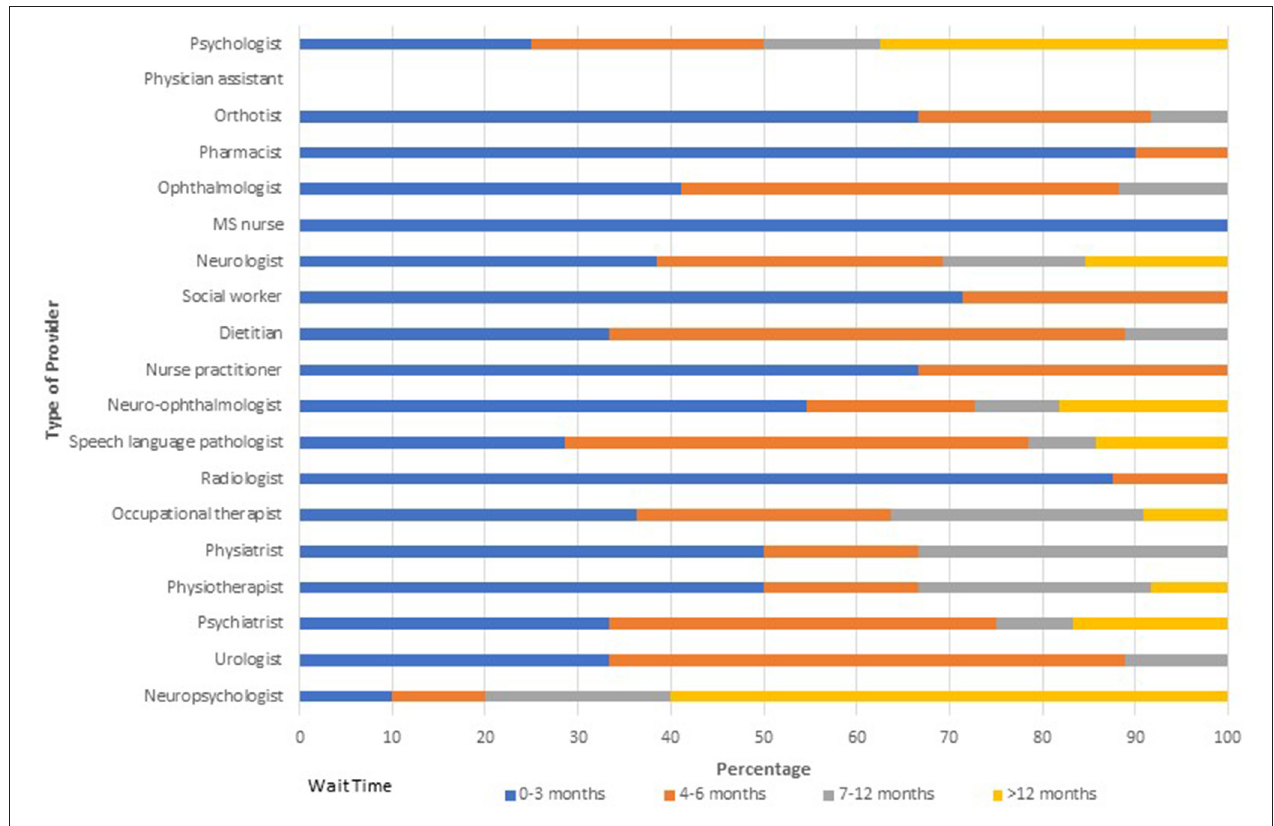
FIGURE 2 | Wait times for providers external to multiple sclerosis clinics.